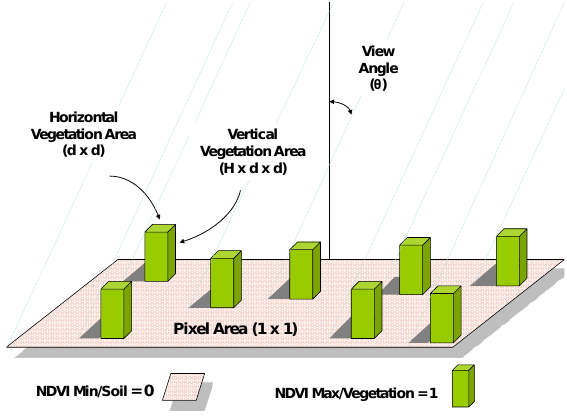
Figure 1. Prisms of vegetation are depicted on a flat surface of soil with an area of soil obscured via the vegetation prism based on the viewing geometry of the